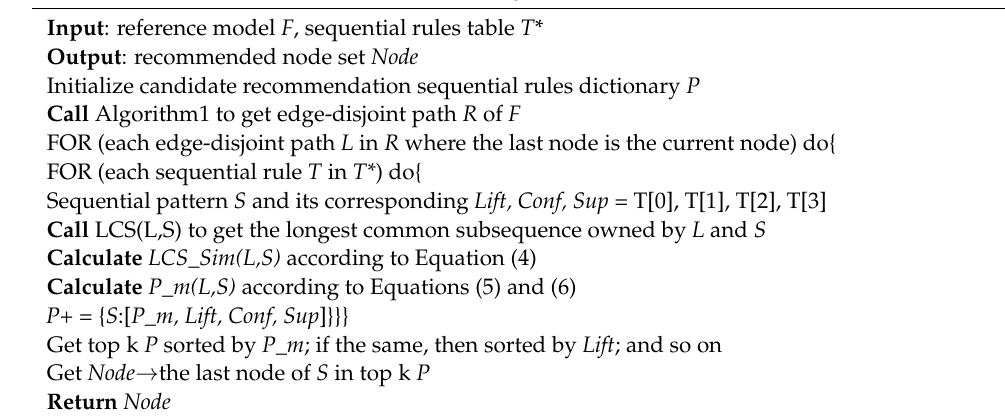
Algorithm 3. Process node recommendation